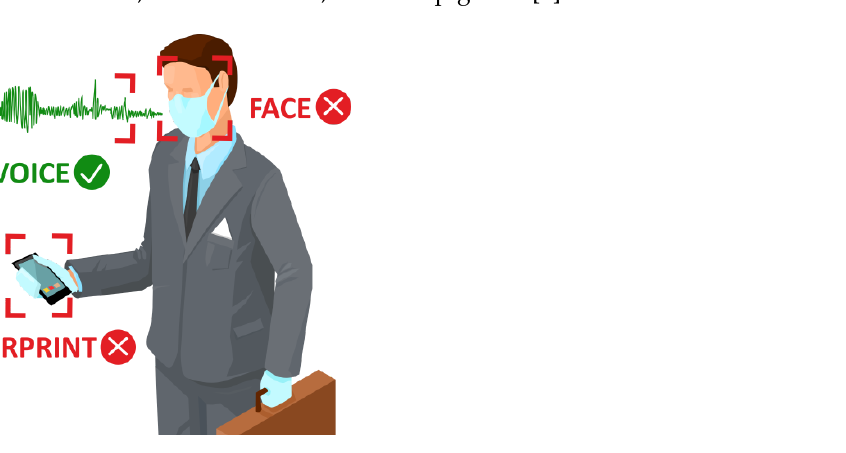
Figure 1. Advantage of voice biometrics over face and fingerprint biometrics during COVID-19 pan- demic.